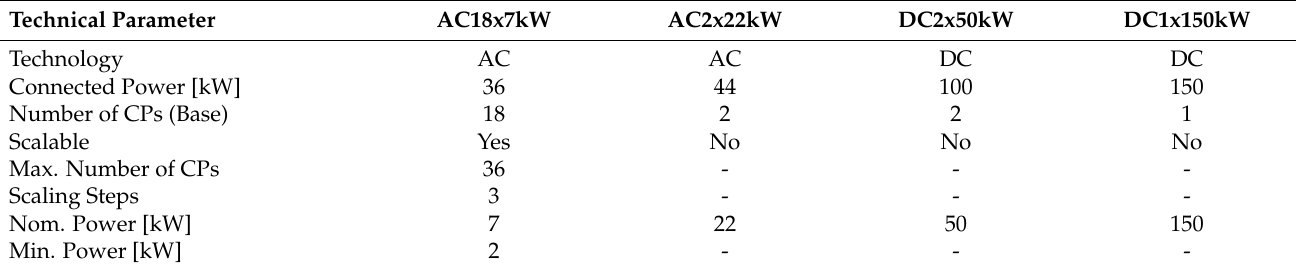
Table 2. Technical Parameters of the Investigated Charging Concepts.